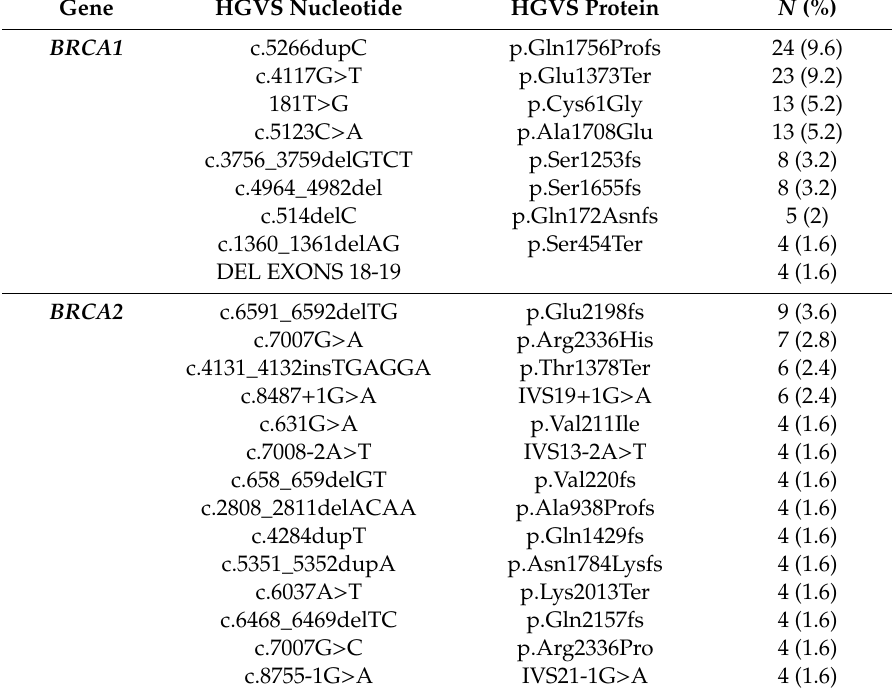
Table 4. Recurring pathogenic variants among BC and OC